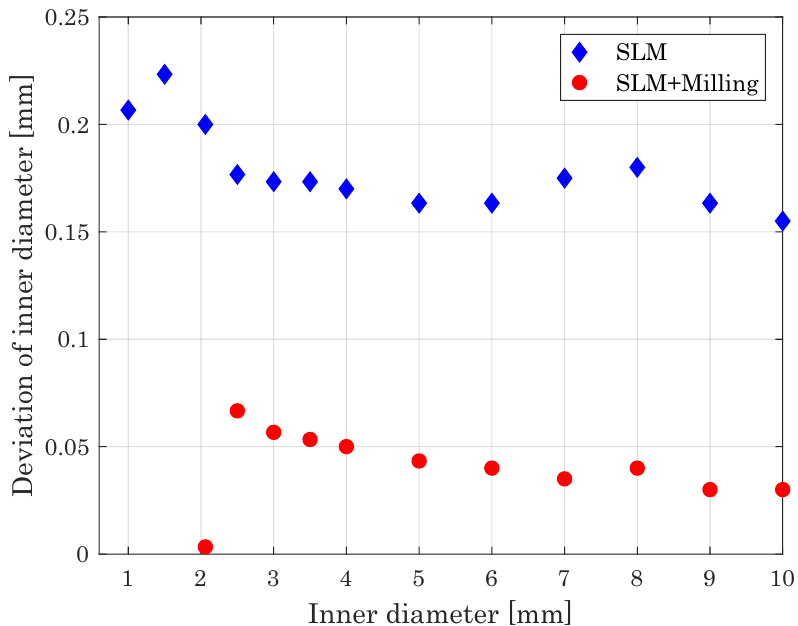
Figure 15. Deviation of inner diameter of spheres versus intended inner diameter, giving a measure of the dimensional accuracy of the processes.